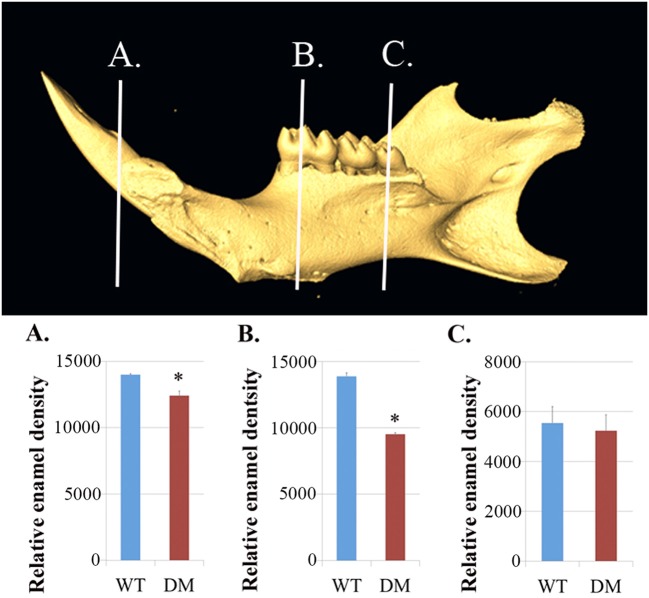
Quantification of enamel density in wild-type and double-mutant mandibular incisors. WT, Wild-type; DM, Double-mutant. (A) At the first reference plane, the double-mutant enamel density was approximately 14.3% lower than that of wild-type enamel (P = 0.015). (B) At the second reference plane, the density gap between double-mutant and wild-type enamel was even higher—35.7% (P = 0.010). (C) The difference in relative enamel density of mandibular incisors was not significant between the wild-type and double-mutant groups (P = 0.56). *P < 0.05.